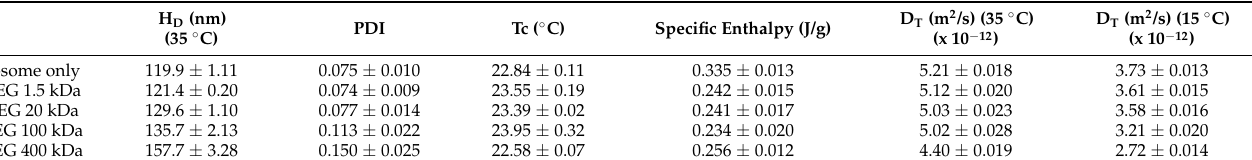
Table 1. Hydrodynamic diameter, polydispersity index (PDI), crystallization temperature (T c ), and translational diffusion constant (D T ) at 35 ◦ C and 15 ◦ C of neat 20 mg/mL 100 nm DMPC/DMPG liposomes and in PEG solutions with varying molecular weights.